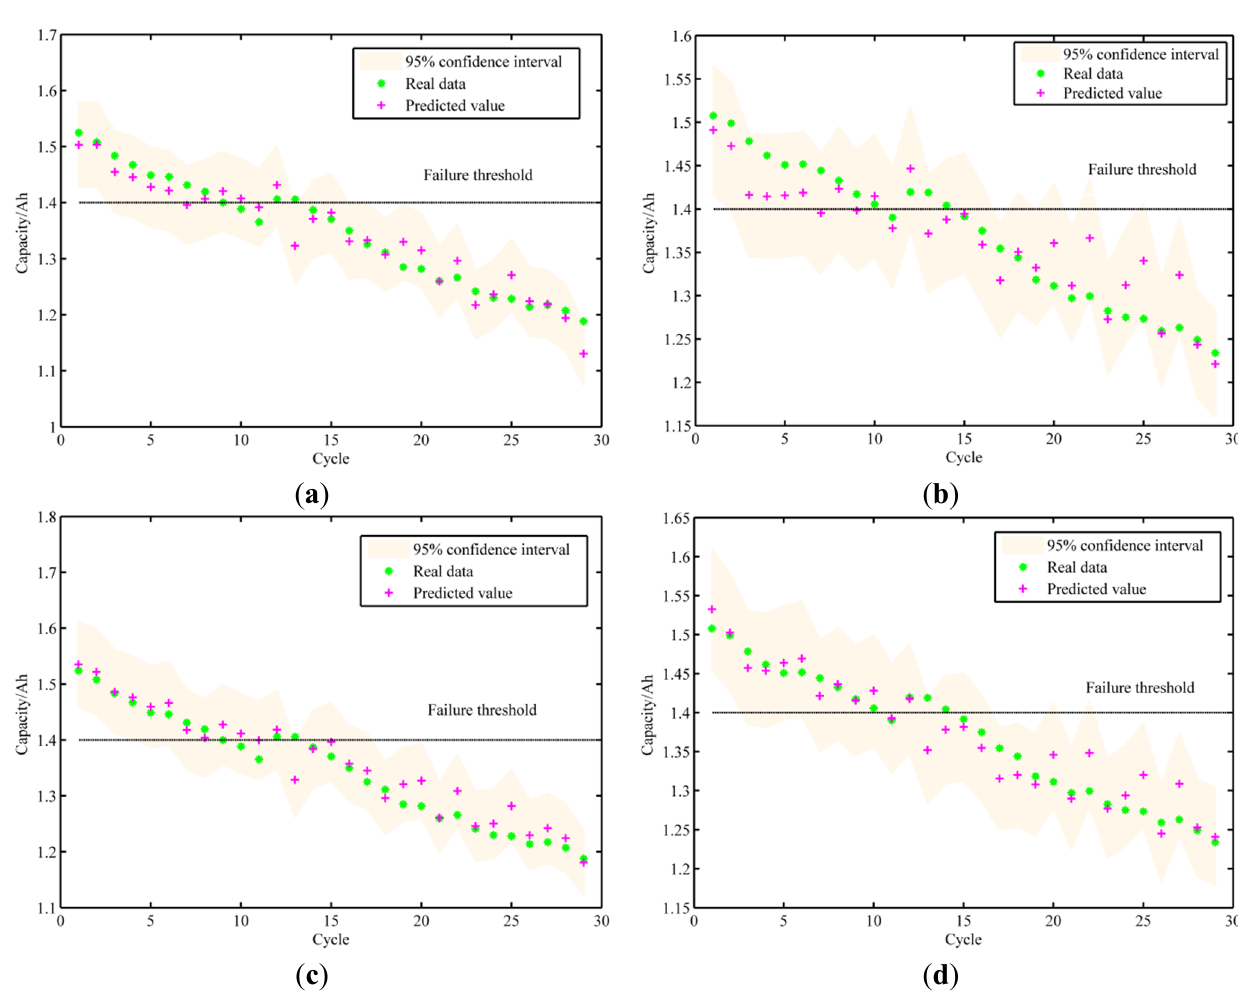
Figure 6. Comparison between the results obtained from the results of the SVR and F-SVR methods at an ambient temperature of 4 °C. Predictive results of the SVR method for: ( a ) Battery No. 47; and ( b ) Battery No. 48. Predictive results of the F-SVR method for: ( c ) Battery No. 47; and ( d ) Battery No. 48.